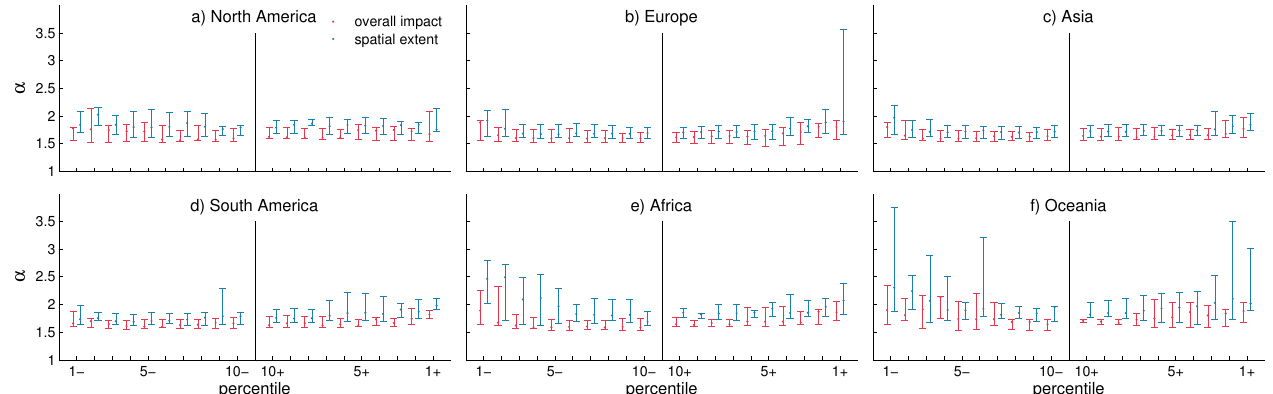
Figure 2. Values of the power-law exponent α for the overall impact (blue) and spatial extent (red) of extremes in GPP. Shown are the median (dot) and the range of the data sets MTE, MOD17+, LPJmL, OCN and AVG for the positive ( + ) and negative ( − ) extremes for the percentiles 1 to